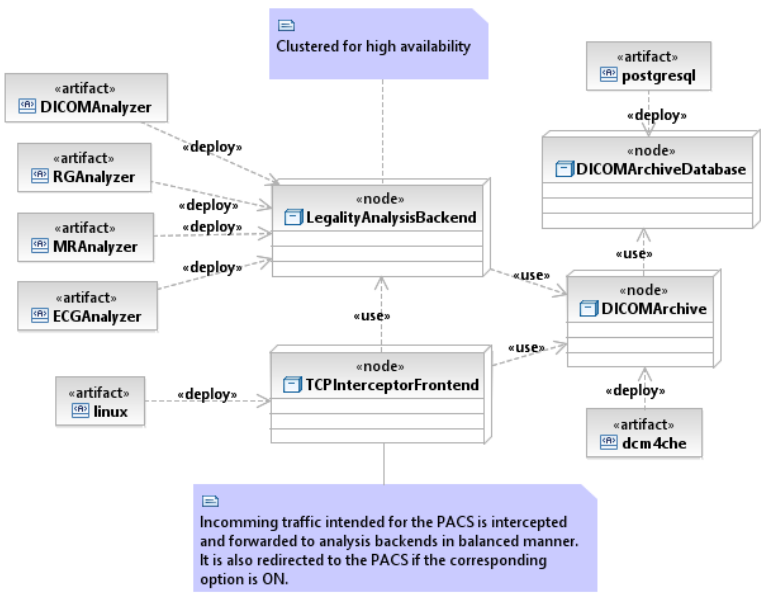
Figure 3. Deployment diagram of the subsystem for medical data analysis.